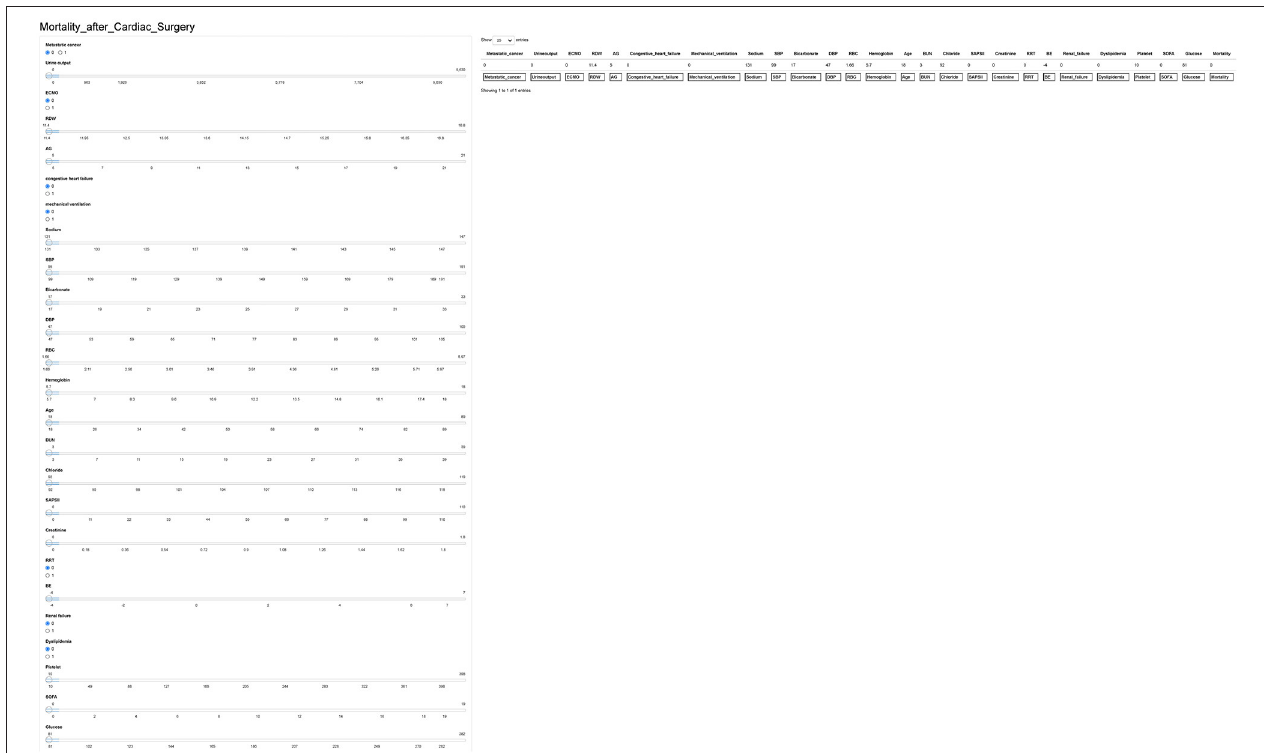
FIGURE 7 | Interface of website usage. RDW, red blood cell distribution width; BUN, blood urea nitrogen; SAPS II, Simplified Acute Physiology Score II; AG, anion gap; SOFA, Sequential Organ Failure Assessment; SBP, systolic blood pressure; RRT, renal replacement therapy; RBC, red blood cell; ECMO, extracorporeal membrane oxygenation; BE, base excess; DBP, diastolic blood